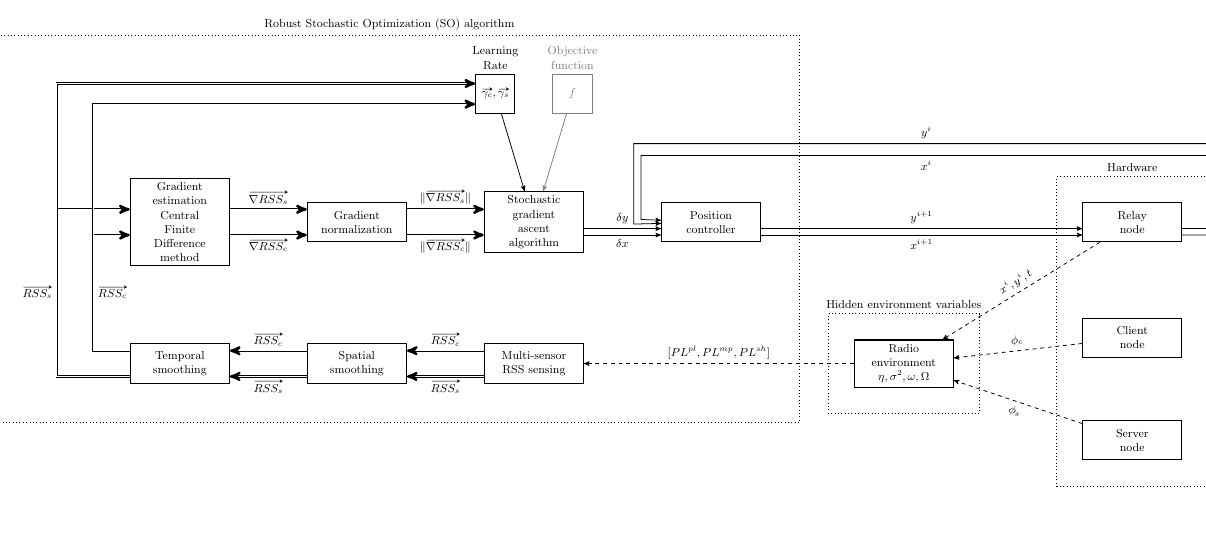
Figure 5. Schematic view of the proposed position controller implementing the robust stochastic optimization